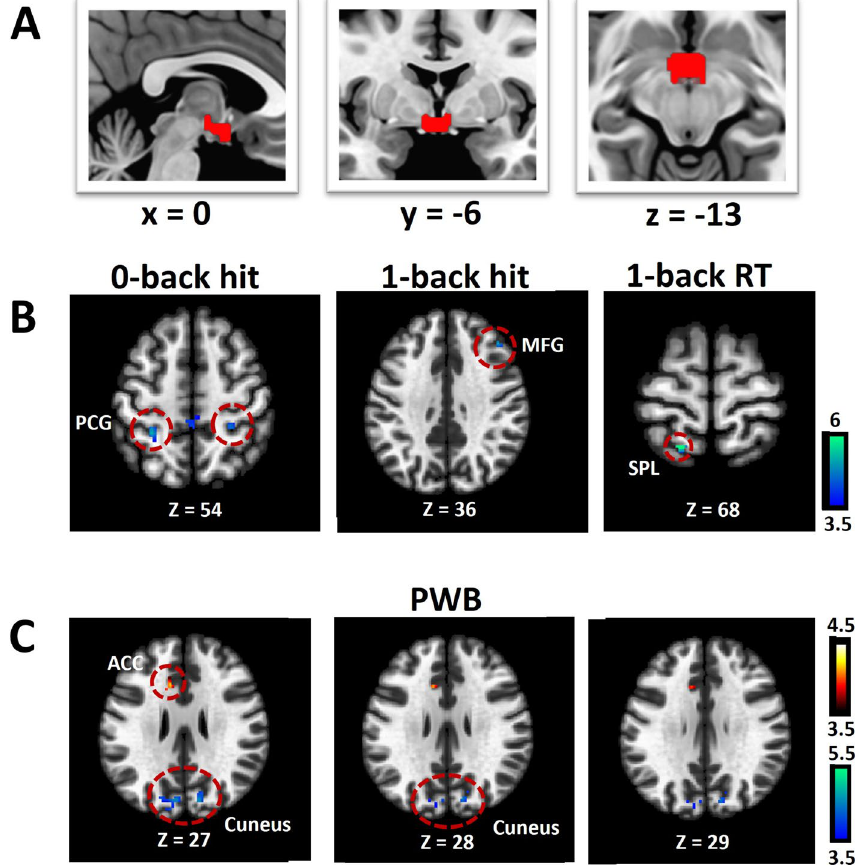
Figure 2. Hypothalamus ( A : seed) rsFC correlates of change (follow-up versus baseline) in N-back scores ( B ) and QoL sub-score PWB ( C ) in ADT. The clusters were obtained using whole-brain regression with baseline age, education, MoCA as covariates, at cluster p < 0.05 FWE-corrected and cluster-forming voxel p < 0.001, uncorrected. Color bar shows voxel T-values. Warm/cool colors: positive/negative correlations. Hit: correct response rate (%), RT: reaction time (ms), PWB: physical